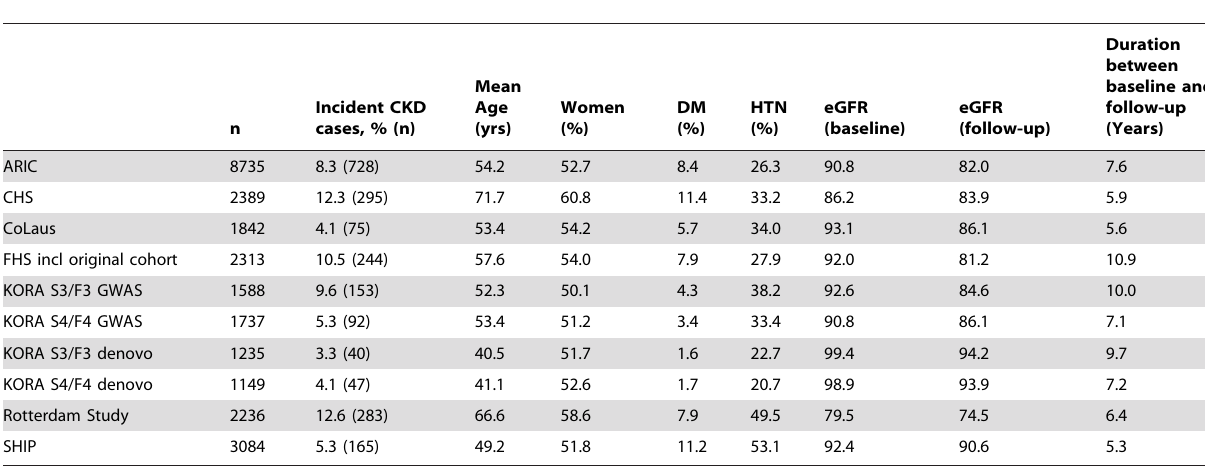
Table 1. Cohort characteristics of the incident CKD analysis